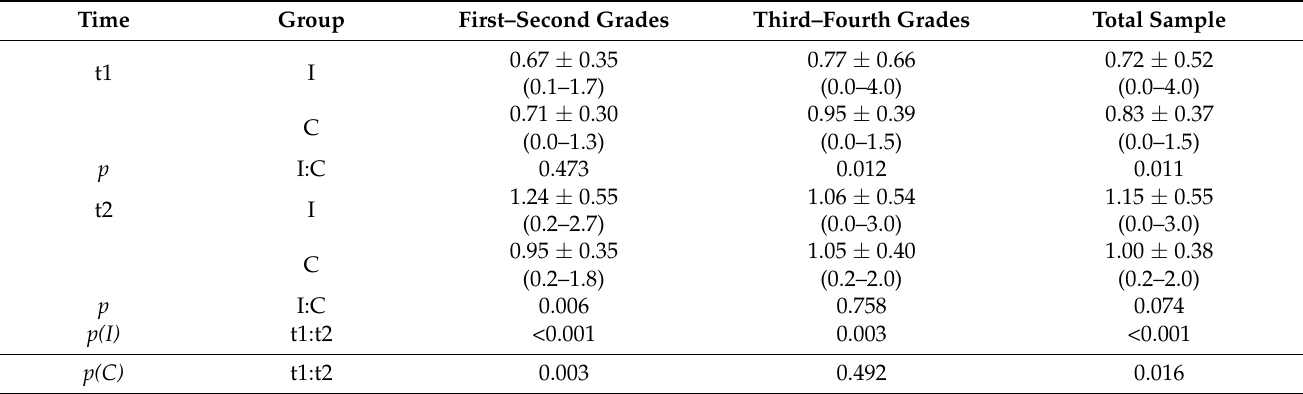
Table 3. Average daily intake of vegetables (servings) in first–second-grade and third–fourth-grade subgroups of the I group and the C group in t1 and